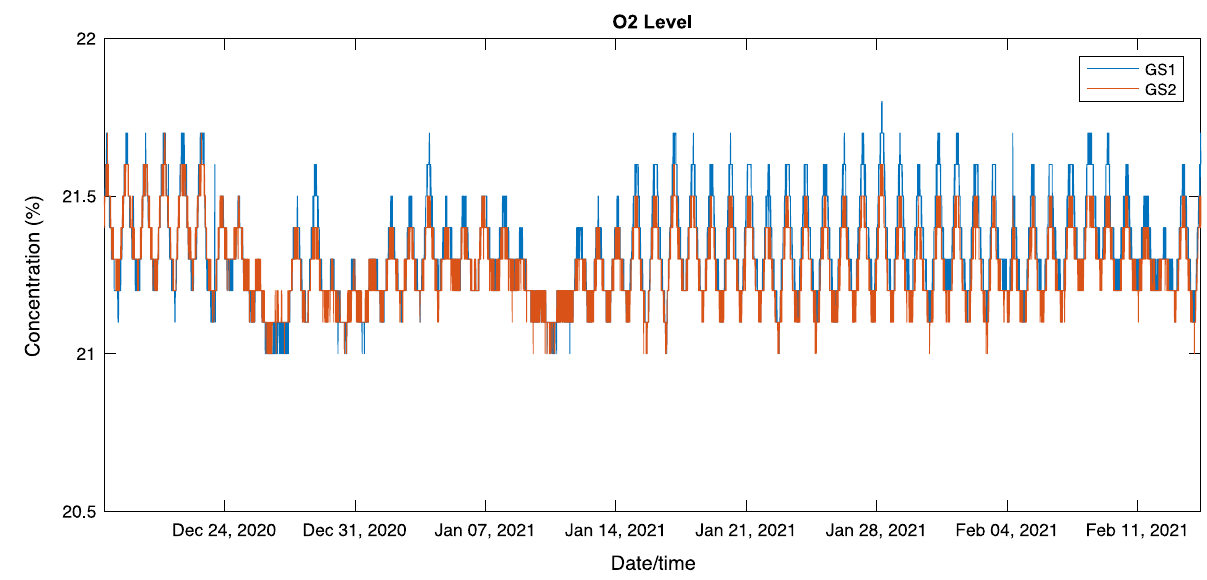
Fig. 10 Oxygen levels as report by both stations with an average of 21.3% ± 0.2% for GS1 and 21.3% ± 0.1% for GS2